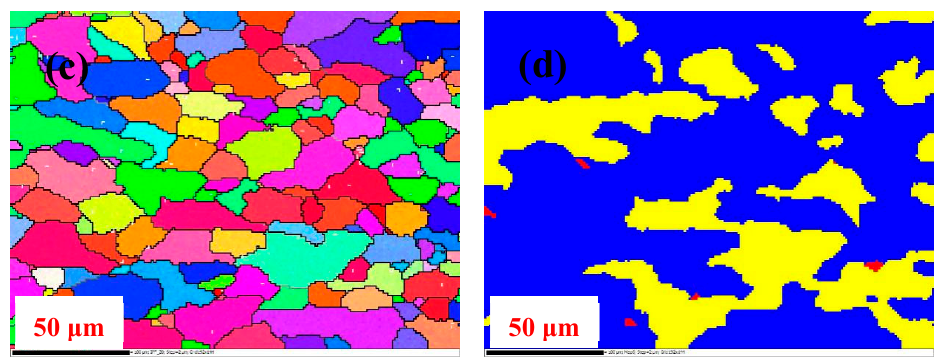
Figure 12. EBSD images of grain structure for the two different homogenized samples subjected to hot deformation and T6 treatment: ( a ) orientation map and grain boundary map of homogenized sample with T6 treatment after forging; ( b ) the corresponding recrystallization map of forged and T6-treated sample (with homogenization); ( c ) orientation map and grain boundary map of nonhomogenized sample with T6 treatment after forging; ( d ) the corresponding recrystallization map of forged and T6-treated sample (without homogenization).